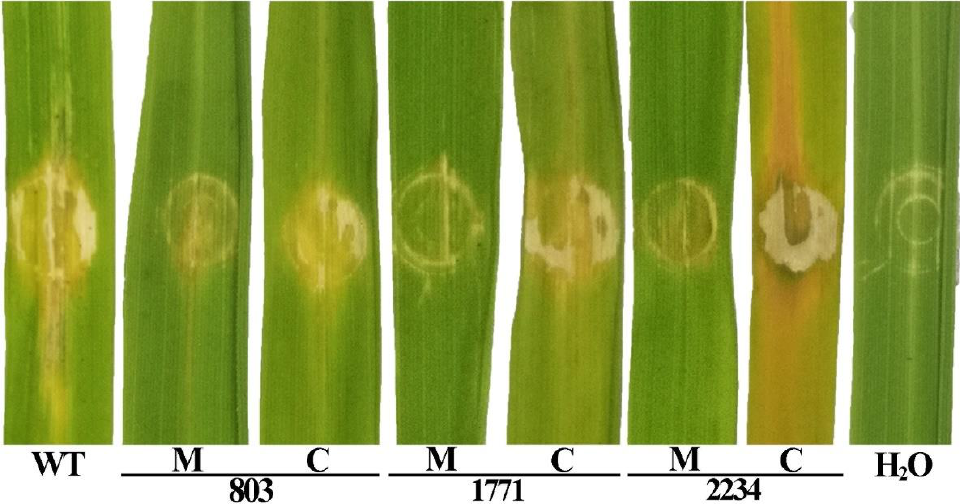
Figure 6. Influence of the 3 Tn5 mutants M488, M722 and M1070 in pathogenicity was justified by infiltration inoculation of knockout mutants and complemented strains of the corresponding location genes on rice leaves. WT: Wild type; H 2 O: Negative control; M: Knockout mutant; C: Comple- mented strains.